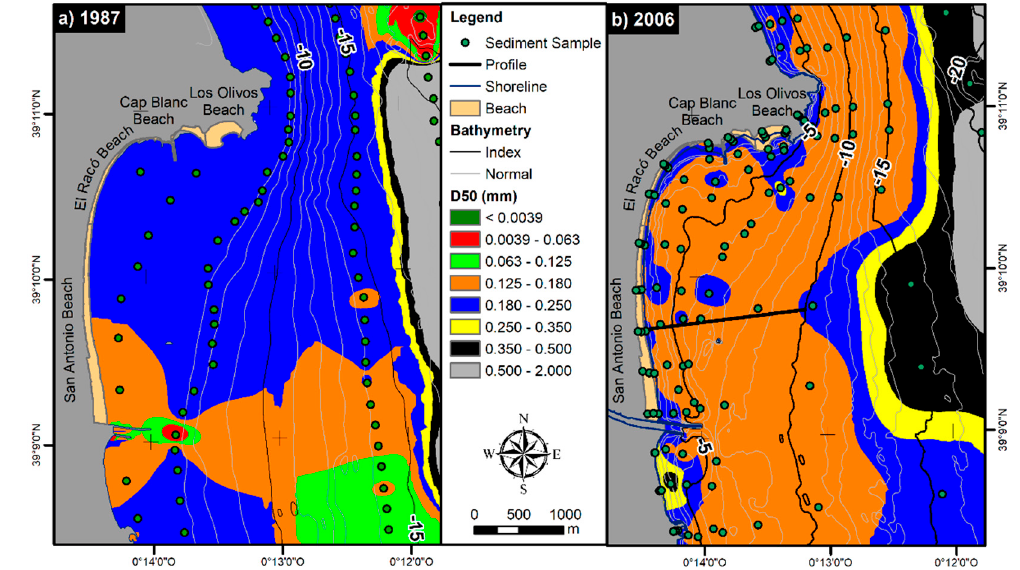
Figure 6. Distribution of the median sediment size in 1987 ( a ) and 2006 ( b ).